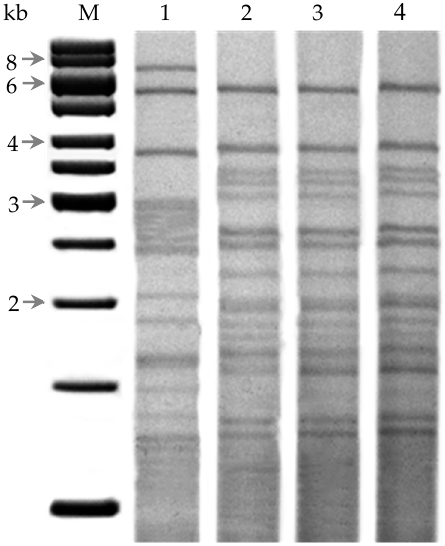
Figure 4. RFLP-mtDNA restriction patters which Hinf I enzyme. Line 1—M: 1 kb GeneRuler DNA Leader; 1—strain A, 2–4—strain B; agarose gel (3%).